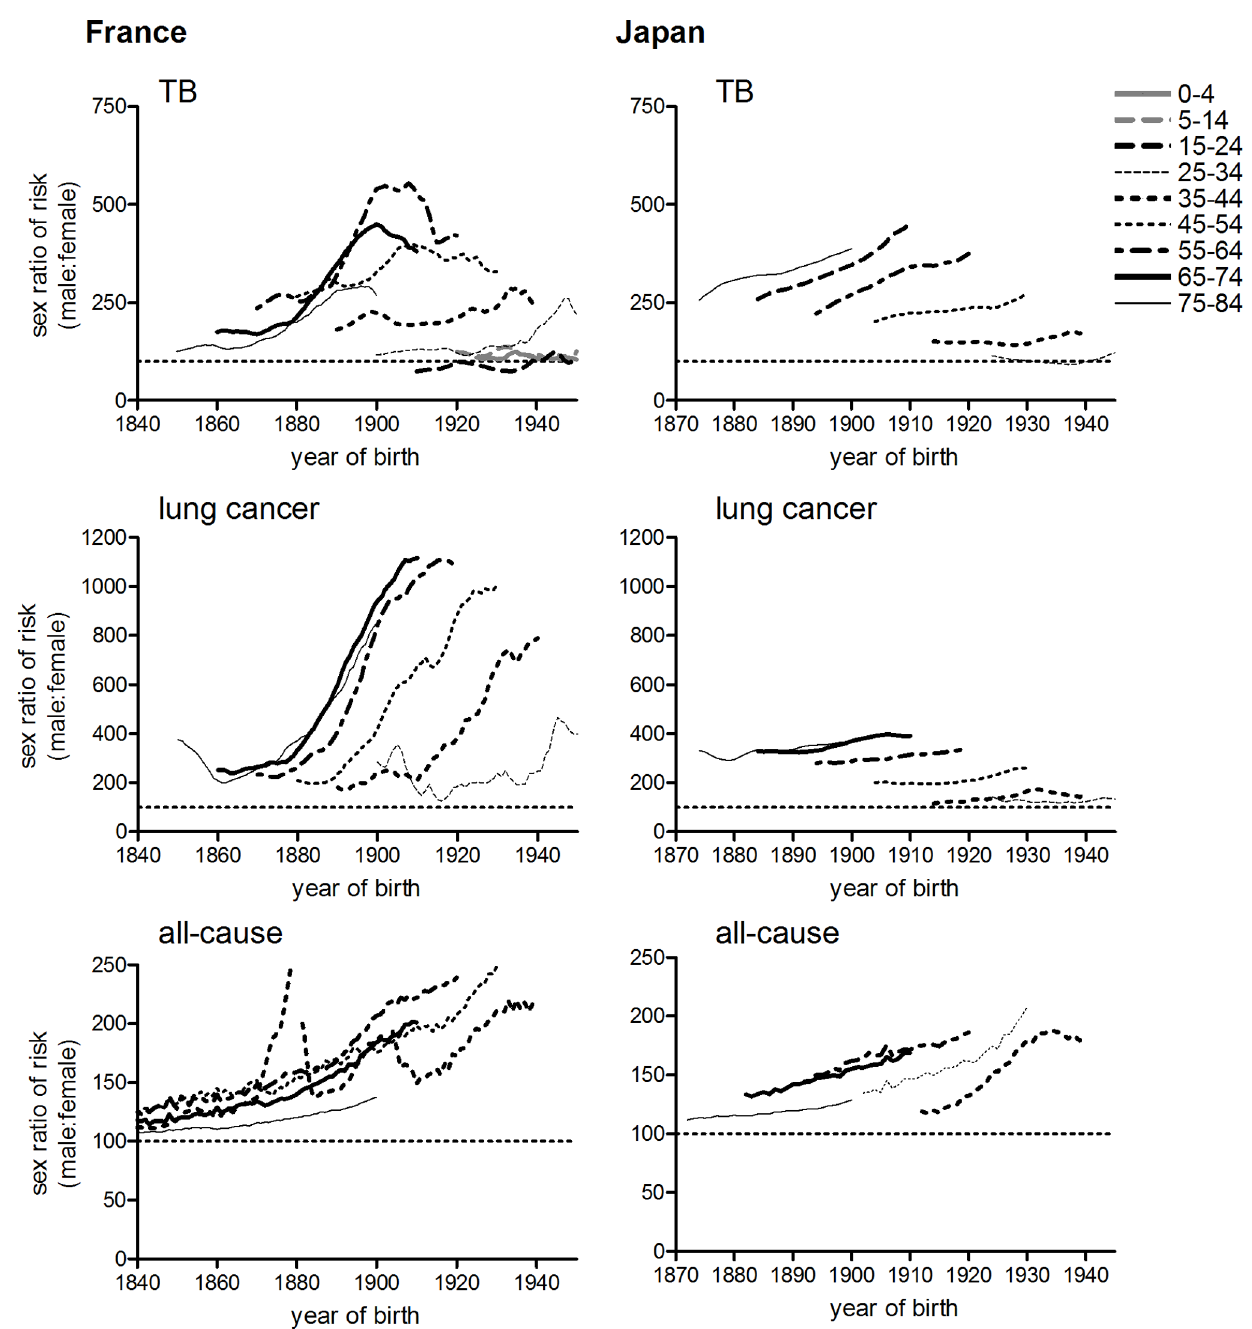
Figure 12. Age-specific sex ratios of tuberculosis, lung cancer and all-cause mortality, by birth cohort: France and Japan. Plots represent all tuberculosis mortality (France) or respiratory tuberculosis (Japan). Data cover the periods described in Table